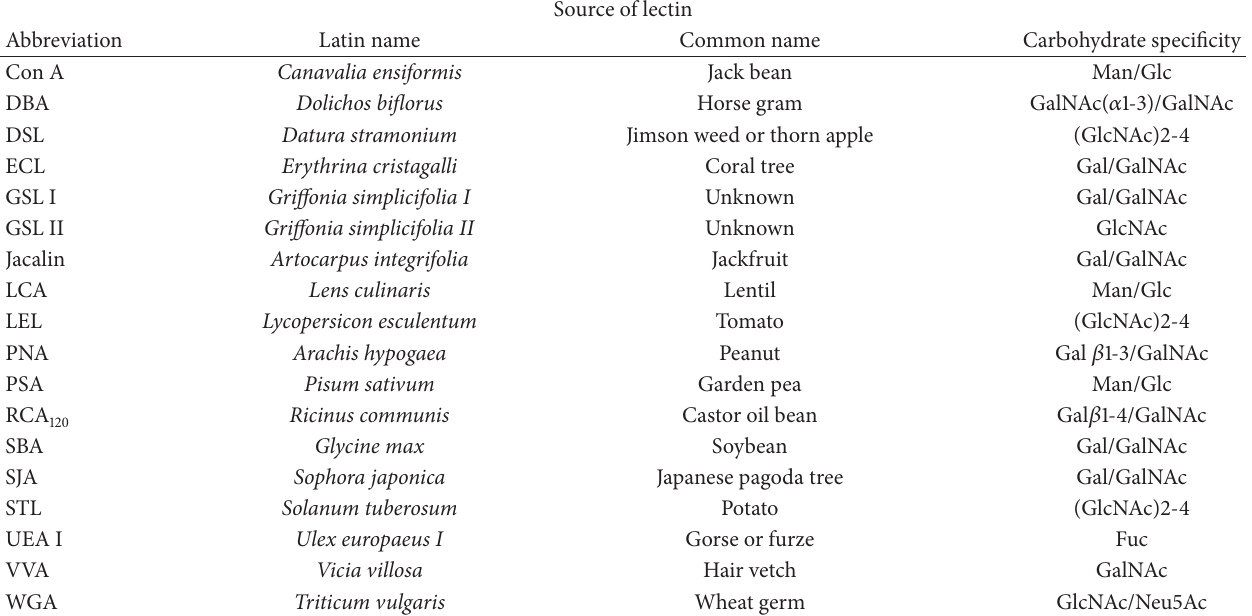
Table 1: Lectins and their characteristics [34, 35, 37]. Man, mannose; Glc, glucose; GalNAc, N-acetylgalactosamine; GlcNAc, N- acetylglucosamine; Gal, galactose; Fuc, fucose; Neu5Ac, N-acetylneuraminic